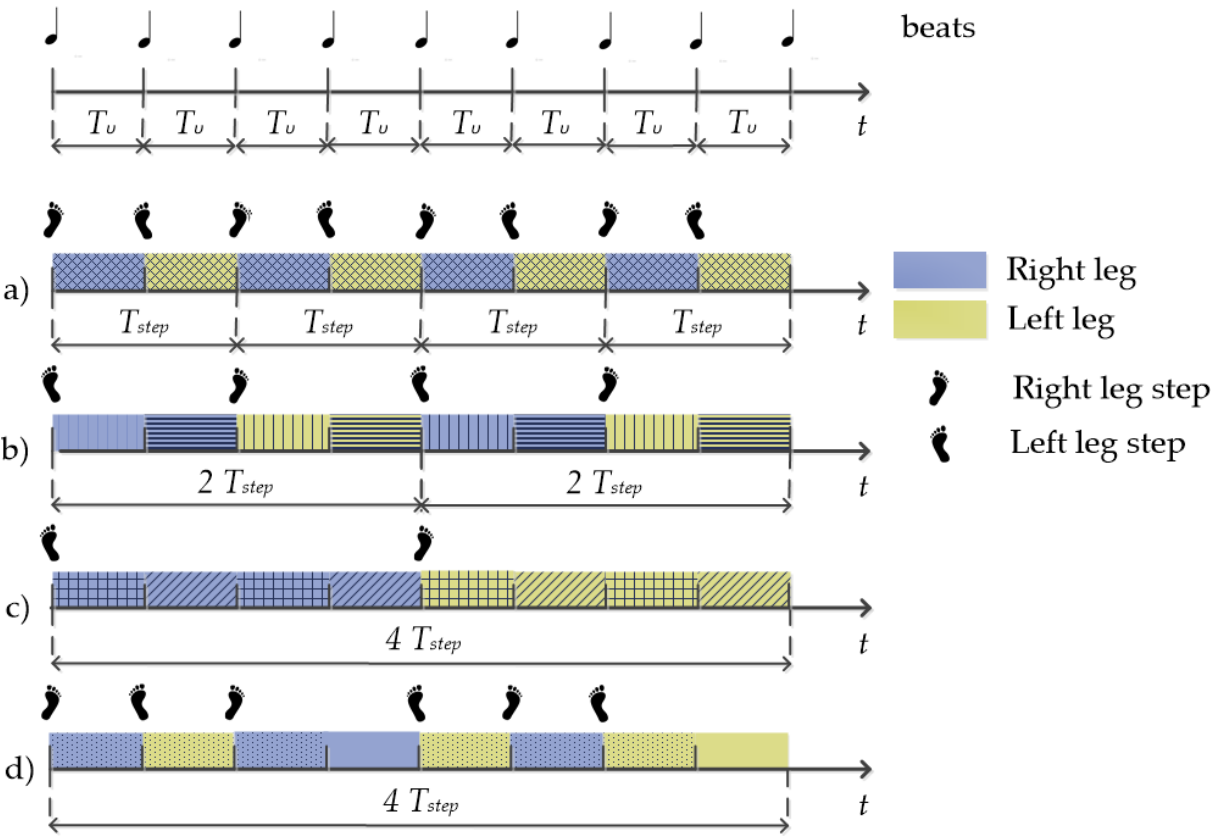
Figure 2. Leg activation patterns in solo jazz dancing. The first row illustrates the music beats that the dancer follows and define the dance tempo. The remaining rows illustrate different examples of leg activation patterns. Periods in which one leg is dominant are color-separated from periods of the other leg’s domination. Different hatch fills emphasize the difference in the executed motion elements. Examples ( a – c ) illustrate patterns of leg change on every beat, every two beats, and every four beats, respectively, while example ( d ) illustrates a more complex leg activation pattern.